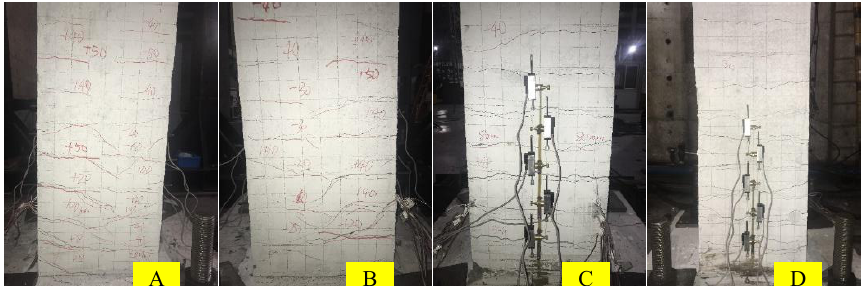
A B C D Figure 12. Crack pattern of the specimen. Figure 12. Crack pattern of the specimen. Note: Side ( C ) was the tension side when the loading direction was positive, whilst Side ( D ) was the tension side when the loading direction was negative. Side ( A ) and Side ( B ) were the lateral sides, which were parallel to the loading